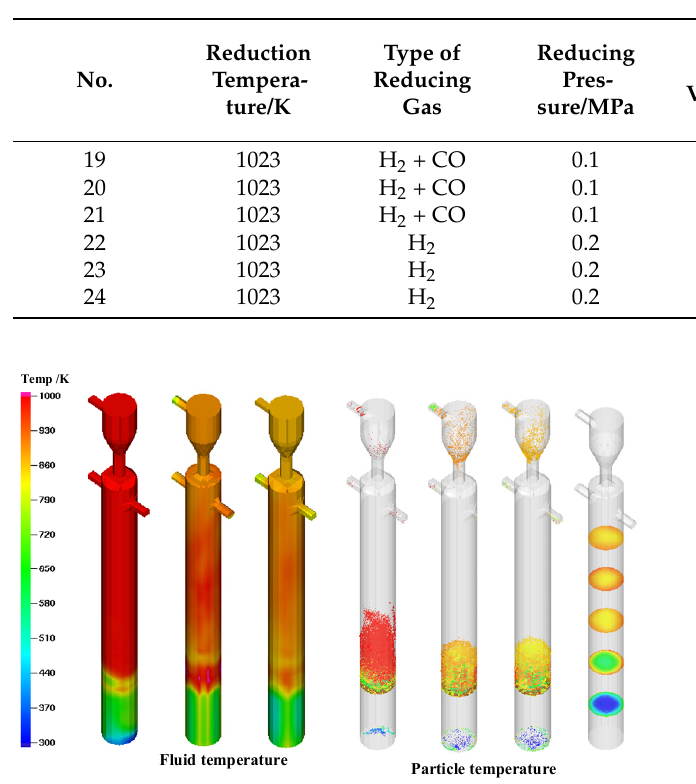
Table 9. Experimental scheme and results.